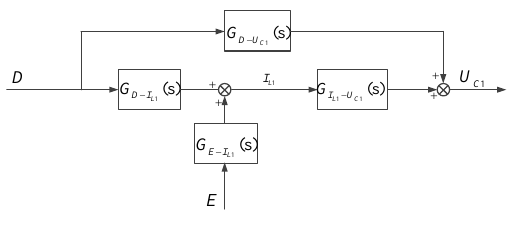
Figure 7. Small signal model.